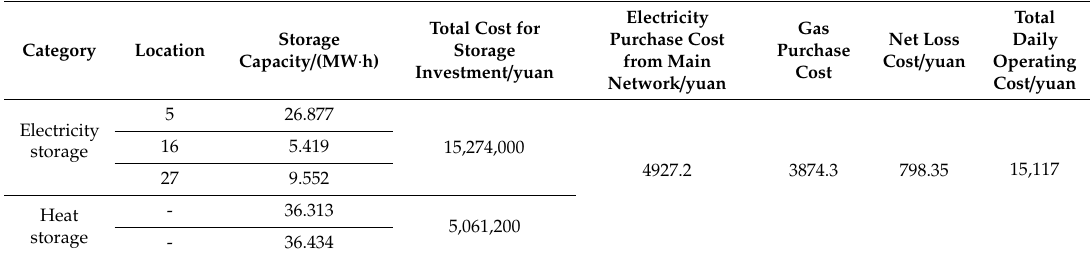
Table 2. Planning